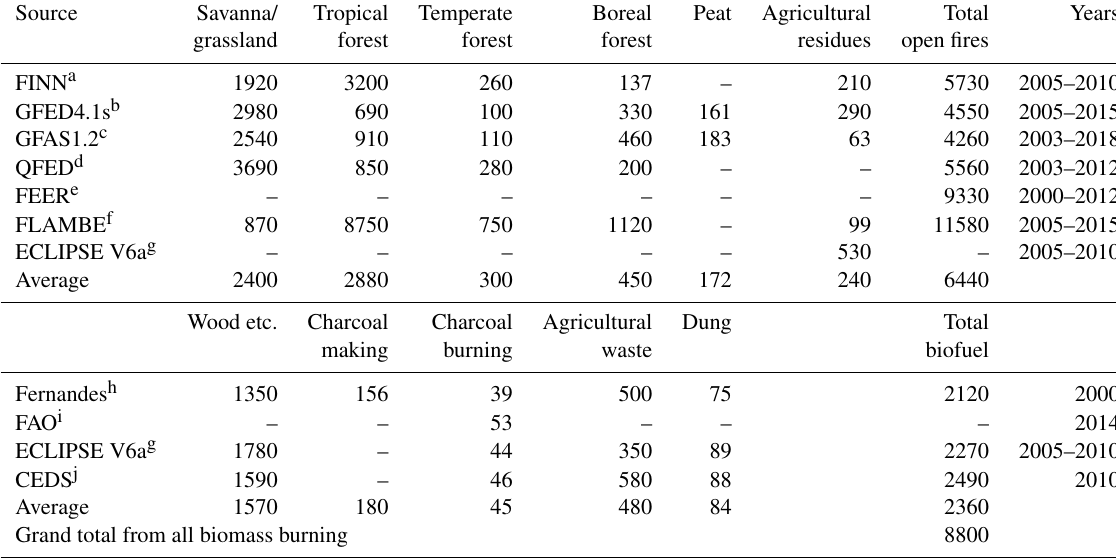
Table 2. Estimates of biomass burned (Tg dry matter) annually in the various fire categories. Source